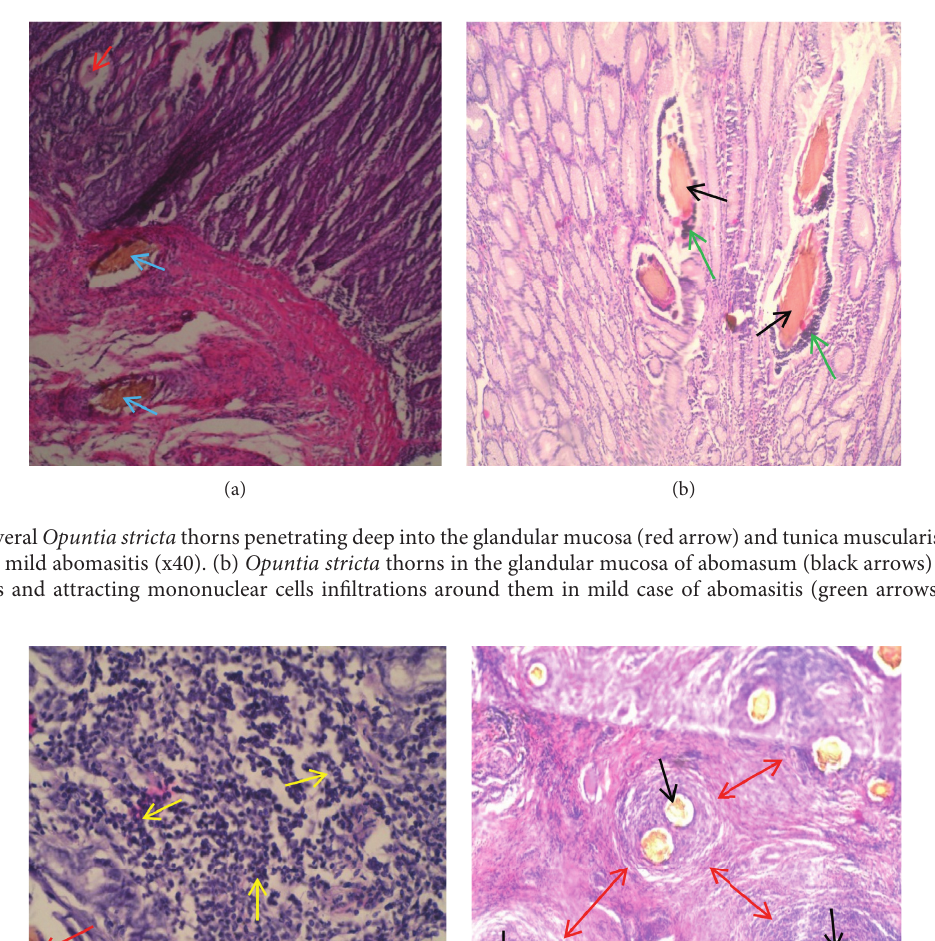
Figure 12: (a) Numerous Opuntia stricta thorns penetrating the tongue (red arrows), completely splitting, destroying, and disrupting the anatomical structure of the organ. Some thorns in the deep tongue muscles are surrounded by mononuclear cells in an acute severe glossitis (yellow arrow) (x10). (b) Opuntia stricta thorns deep in the tongue muscles (green arrows) affecting the sublingual glands in a goat (black arrow) with glossitis (x40).